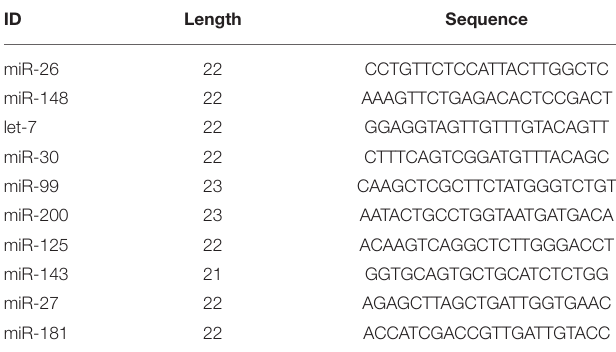
TABLE 3 | The information of top 10 highest expressed miRNA